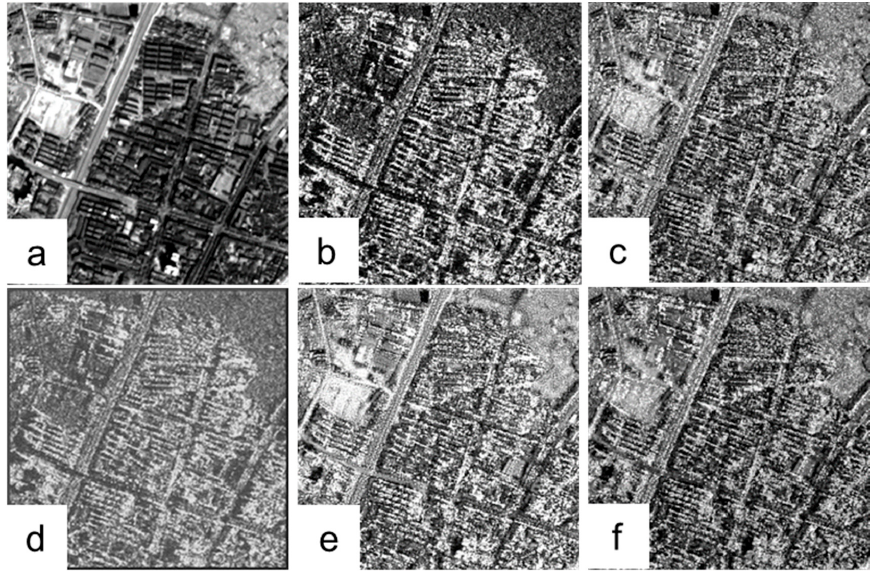
Figure 3. Original SAR and panchromatic images and fused images based on different fusion methods: ( a ) panchromatic image; ( b ) SAR image; ( c ) fused image based on discrete wavelet transform (DWT method); ( d ) fused image based on the à - trous method; ( e ) fused image based on non-subsampled contourlet transform (NSCT) method; and ( f ) fused image based on the proposed BEMD fusion method; The area is the northeast of LingChuan town, and the size of the images was 512 × 512 pixels.